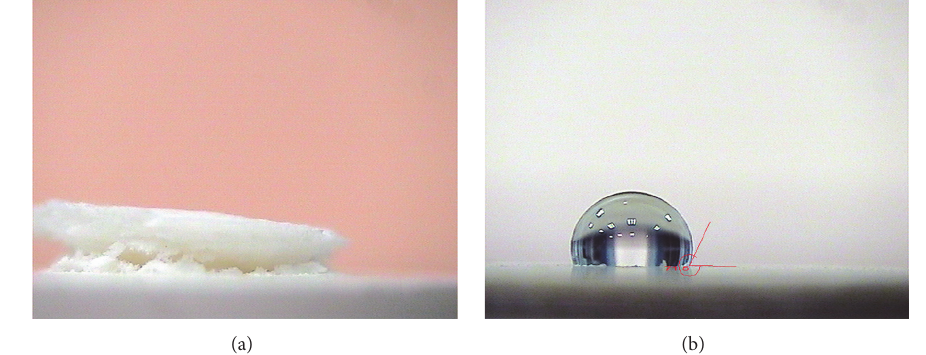
Figure 5: The measurements of contact angle of water on DAS (a) and HDAS